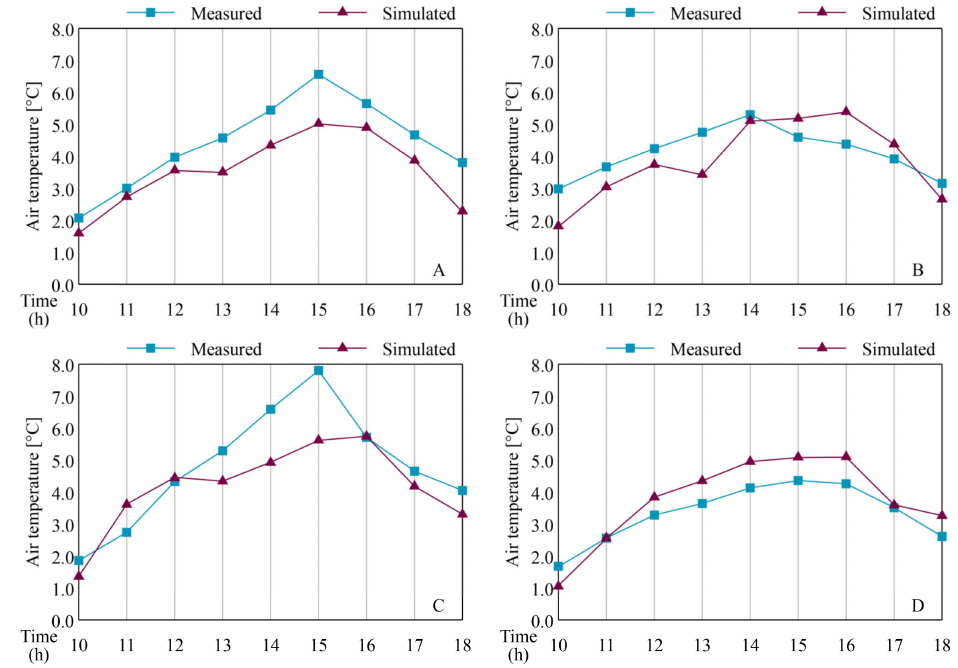
Figure 5. Simulated and measured air temperature at four portable measurement